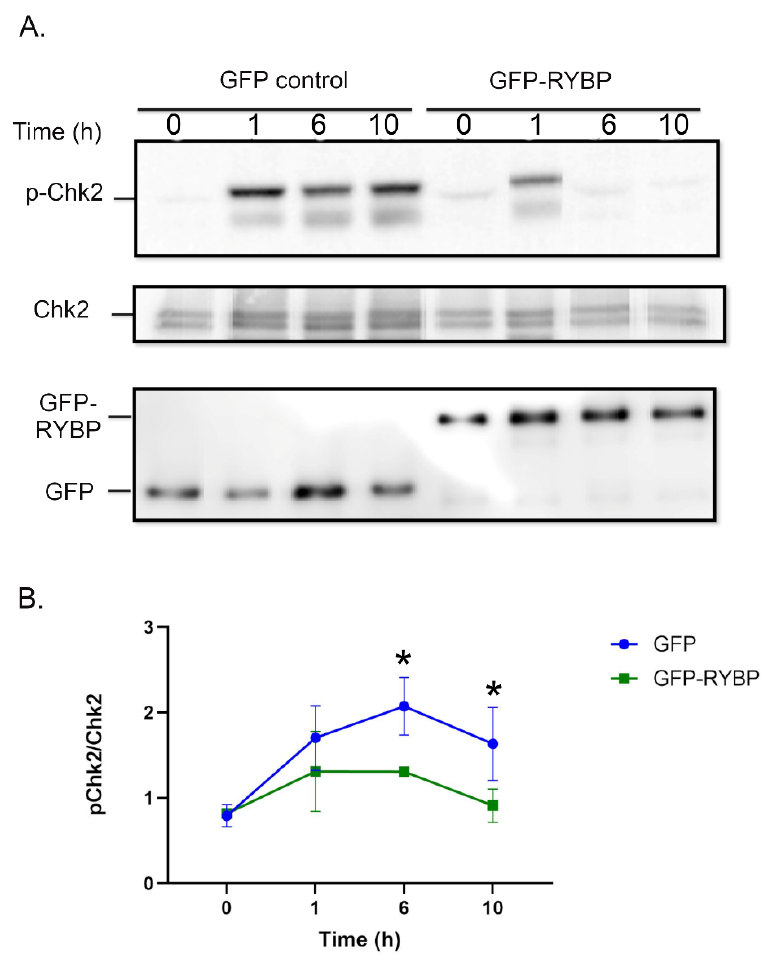
Figure 2. Effect of RYBP expression on phosphorylation of Chk2 after DNA damage. ( A ). Levels of p-Chk2 and total Chk2 are shown after camptothecin (1 µ M) treatment at 0-, 1-, 6- and 10-h time intervals for GFP-control and GFP-RYBP expressing cells. ( B ). Quantification of p-Chk2/Chk2 ratios for GFP-control and GFP-RYBP expressing cells ( n = 3 independent experiments). * p < 0.5 in comparison to 0-h time-point in GFP-control cells (one-way